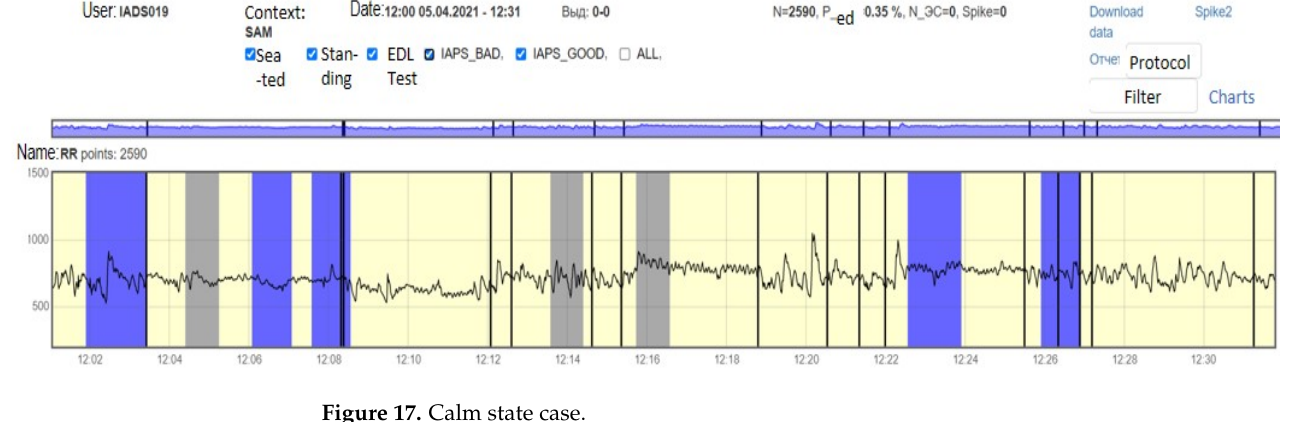
Figure 17. Calm state case.